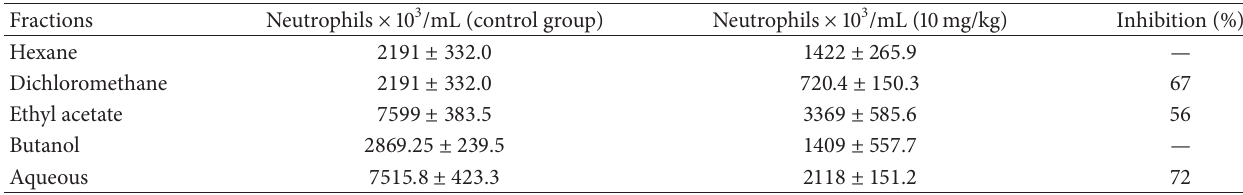
∗ Values are expressed as mean ± S.E.M ( 𝑛 = 5 ; 𝑃 < 0.05 ; ANOVA followed by Bonferroni’s